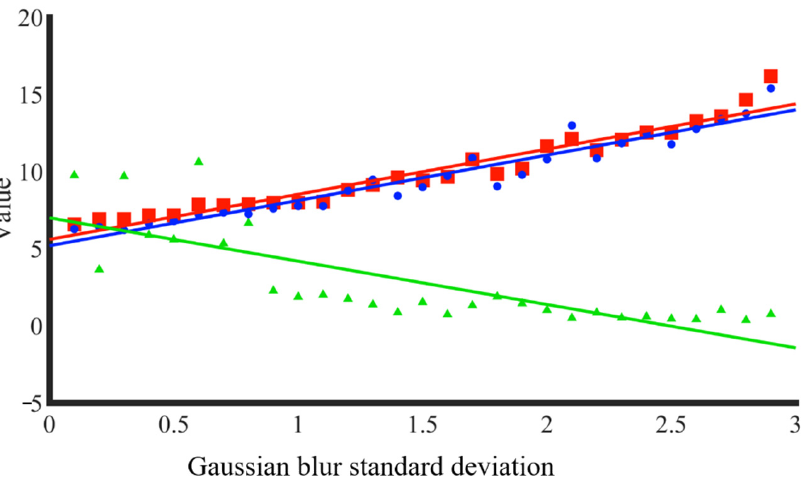
Figure 20. Comparative experiment of image content irrelevance (red represents the method of this paper, blue represents the method of reference [14], green represents the Tenegrad method). Table 2. Performance of the three evaluation methods.